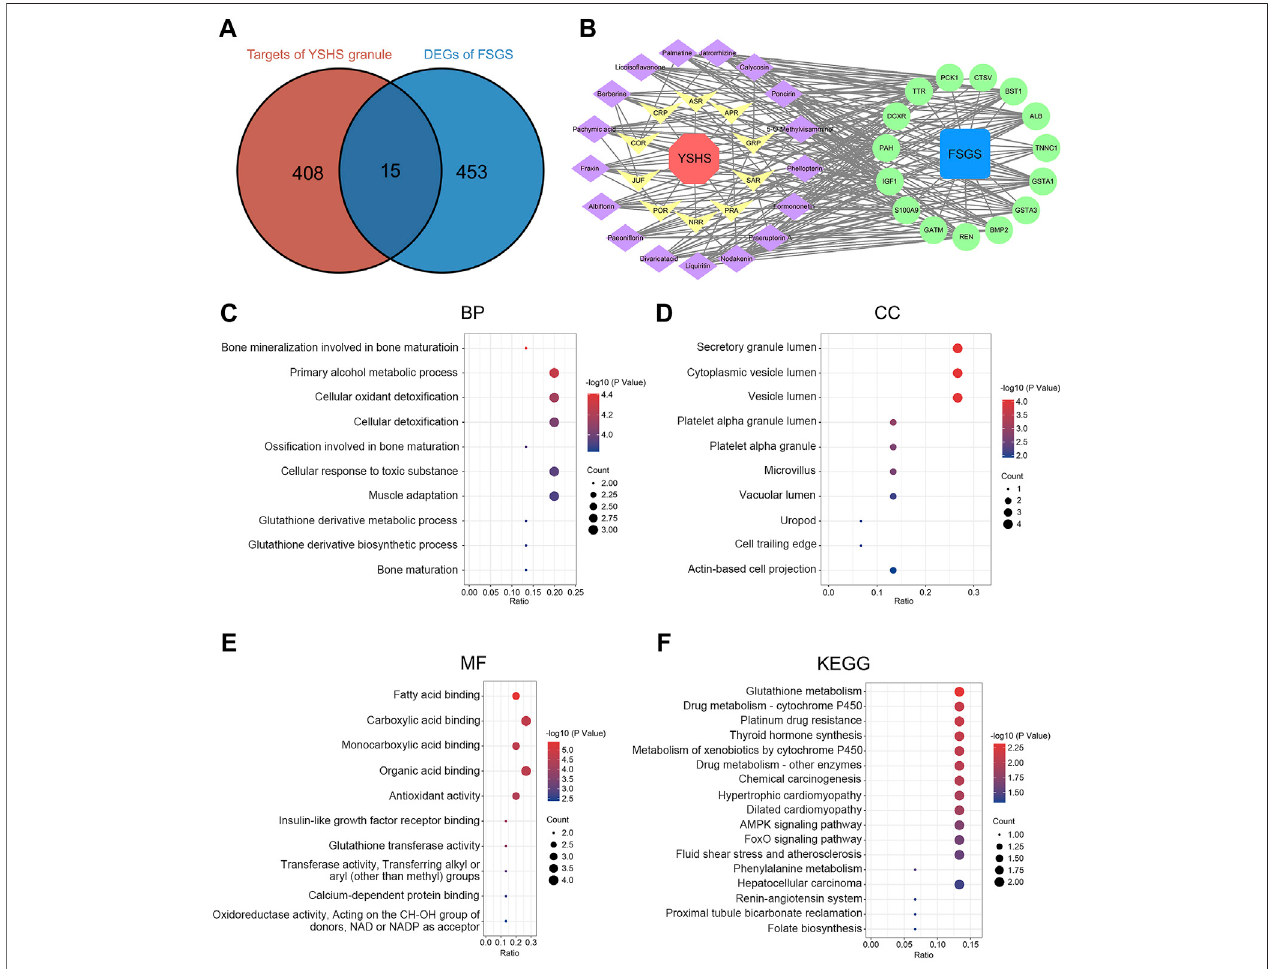
FIGURE4| Identi fi cationandanalysisofthetargetsoftheYSHSgranuleagainstFSGS. (A) VenndiagramofthetargetsoftheYSHSgranuleandDEGsofglomeruli from kidneys with FSGS. (B) A network of the active components of the YSHS granule and the targets of the YSHS granule against FSGS, which was constructed by using Cytoscape. (C – E) The top 10 items of BP (C) , CC (D) and MF (E) in GO enrichment of the targets of the YSHS granule against FSGS. (F) KEGG pathway enrichment of the targets of the YSHS granule against FSGS.